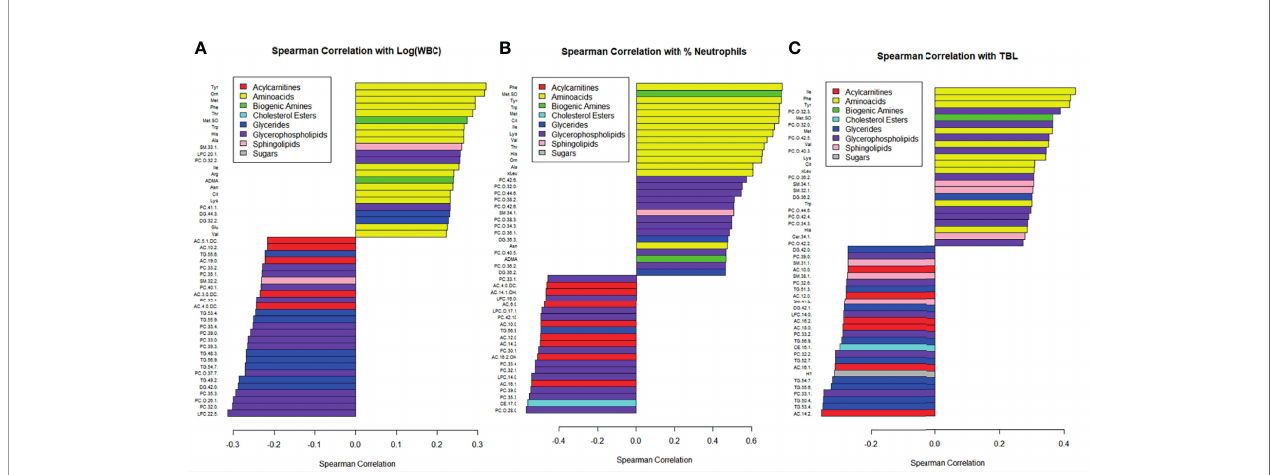
FIGURE 3 | Correlations between metabolite concentrations and (A) the logarithm of white blood cell count, (B) percent neutrophils, and (C) TBL. Bottom of the y- axis are the most negatively correlated and the top of the y-axis are the most positively correlated. Metabolites are color coded by class, and only the 50 most strongly correlated metabolites were